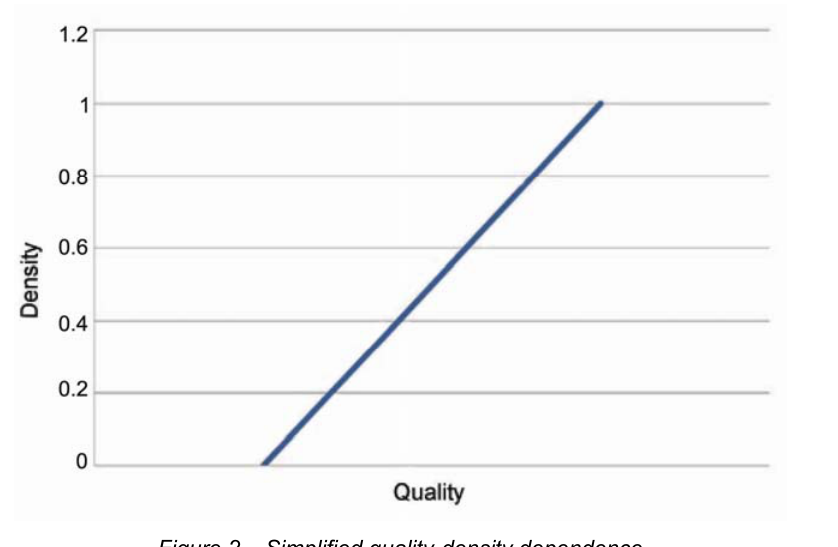
Figure 2 – Simplified quality-density